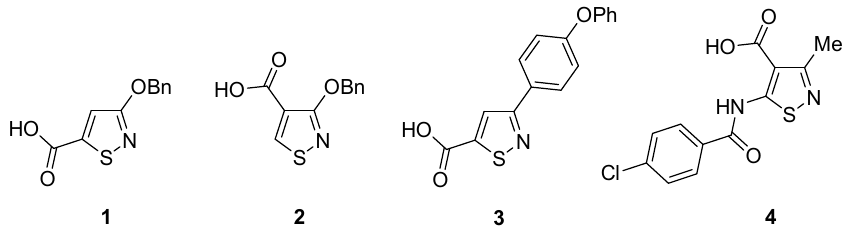
Figure 1. Biologically active isothiazole carboxylates.